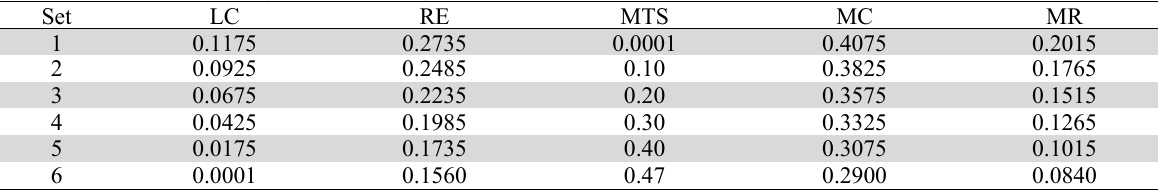
New sets of criteria weights for Example